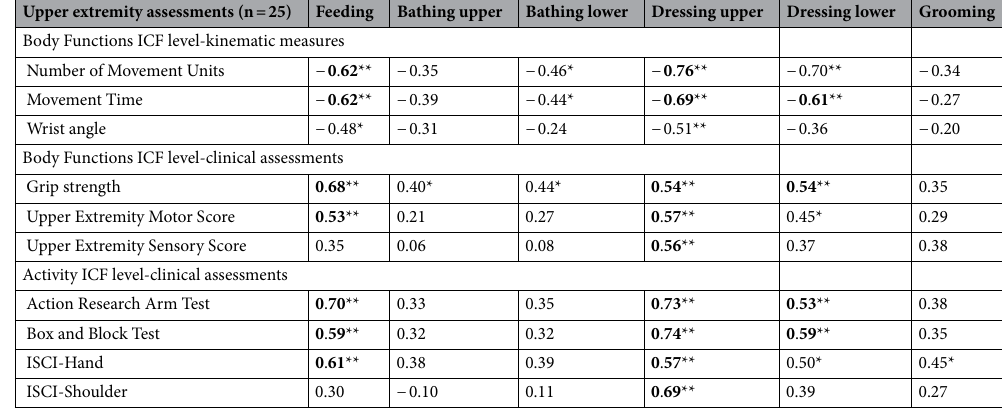
Table 4. Spearman correlation coefficients for each item of the SCIM-self-care subscale and the upper extremity assessments. ** P < 0.01 * P < 0.05 Correlation coefficients > 0.5 are marked with bold. ICF International Classification of Functioning, Disability and Health, ISCI International Spinal Cord Injury Upper Extremity Basic Data Set Form, ISCI-Hand basic Hand variable, ISCI-Shoulder Shoulder variable, SCIM Spinal Cord Independence Measure.